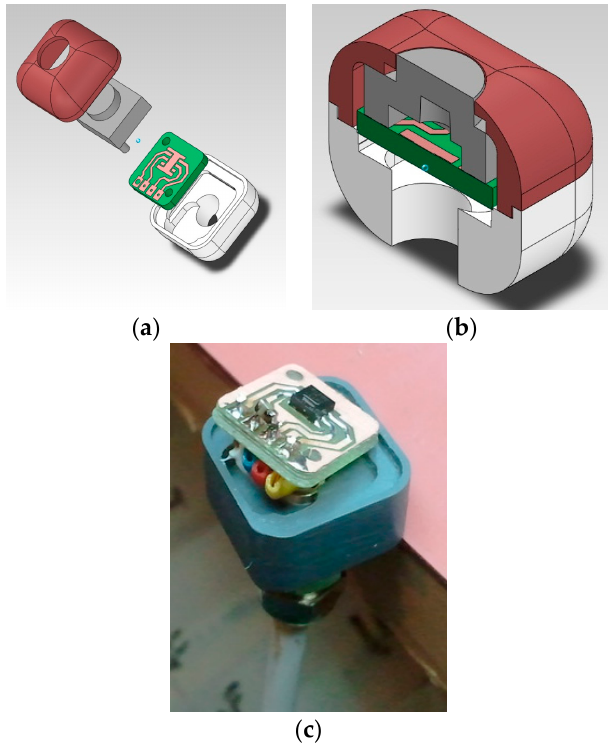
Figure 3. Embedded sensor ( a , b ) Detail of the construction ( c ) Real implementation.